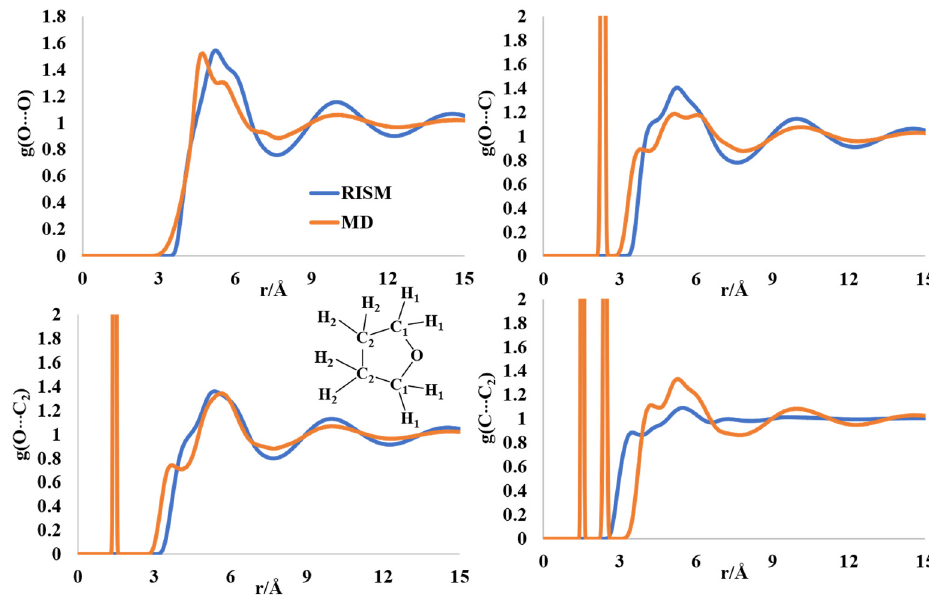
Figure 6. The RISM- and MD-computed distribution functions for liquid THF.